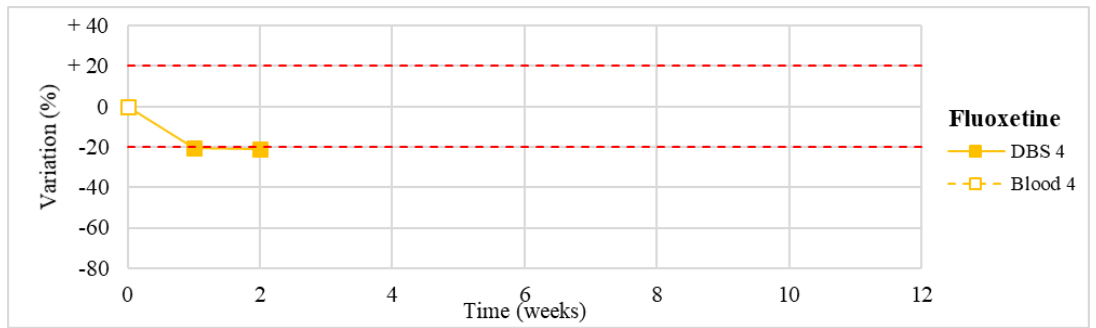
Figure 12. Long-term stability of paroxetine ( n = 1) in DBSs stored at room temperature and in blood stored at −20 °C (T0–T4). Figure 13. Long-term stability of quetiapine ( n = 3) in DBSs stored at room temperature and in blood stored at −20 °C.